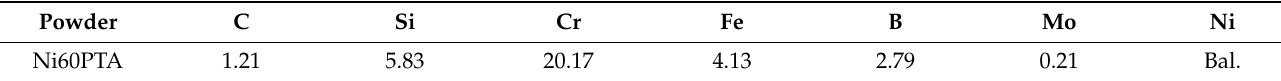
Table 2. Chemical composition of Ni60PTA